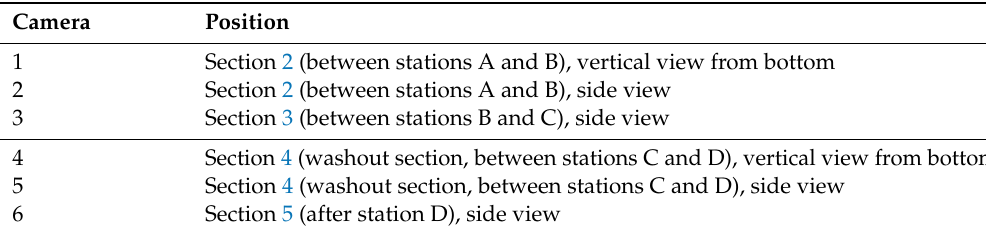
Table 4. Video camera positions.